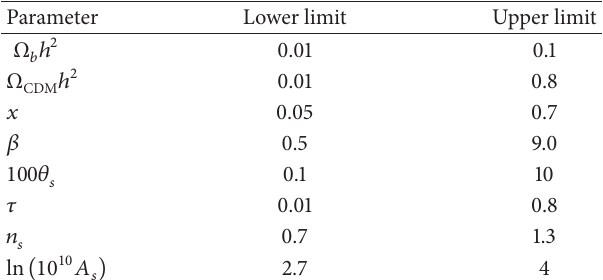
Table 1: Adopted flat priors for the parameters.